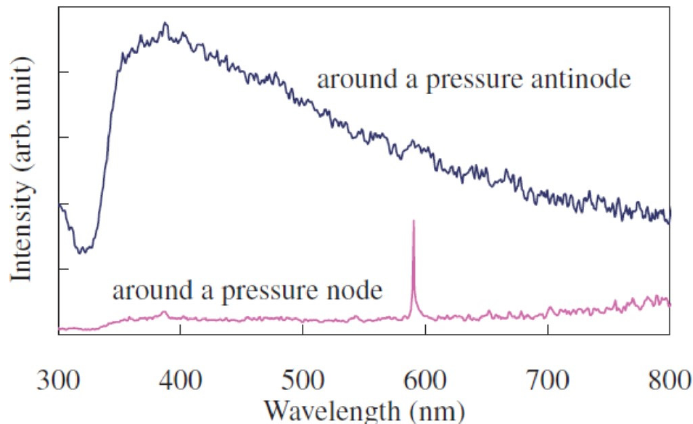
Figure 33. MBSL spectra in the orange region below the pressure node and the blue-white one around the pressure antinode [56]. Copyright 2010, The Japan Society of Applied Physics.